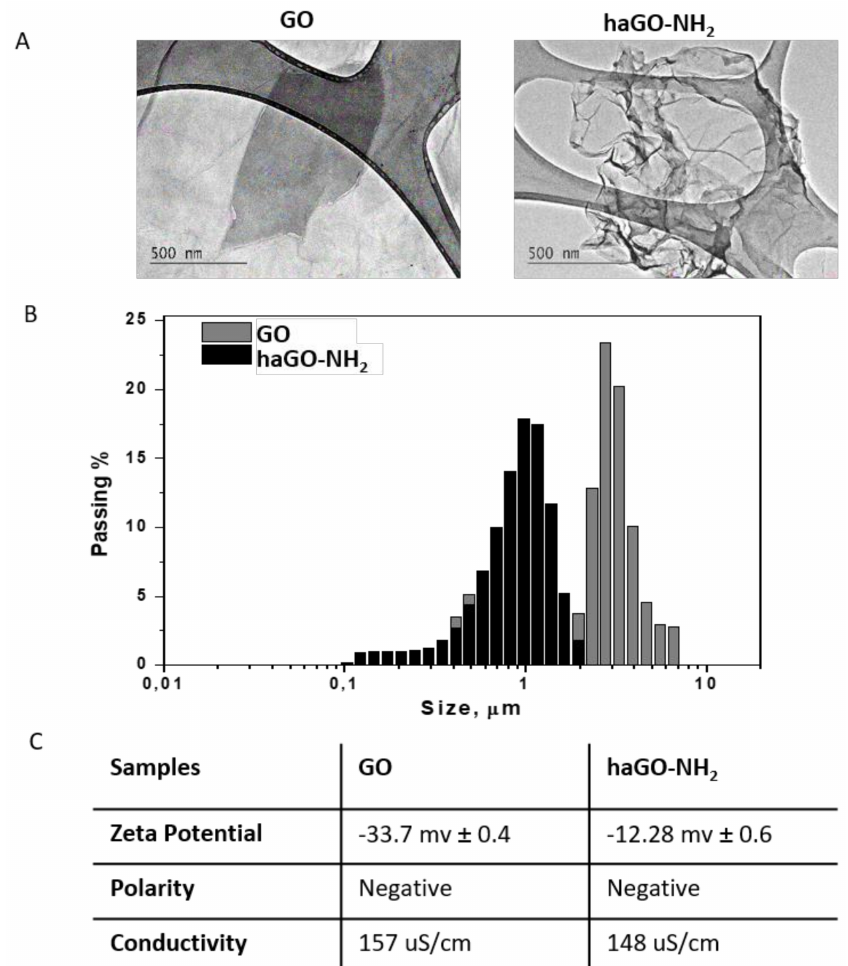
Figure 2. Biophysical characterization of GO and haGO-NH 2 nanoparticles. ( A ) TEM micrographs of GO and haGO-NH 2 . Images were acquired at 200 kV using Holey-carbon film on 300 mesh nickel grids. ( B , C ) Characterization of size and zeta potential of the nanoparticles in solution, were performed on a Zetatrac instrument (S3500; Microtrac, Largo,